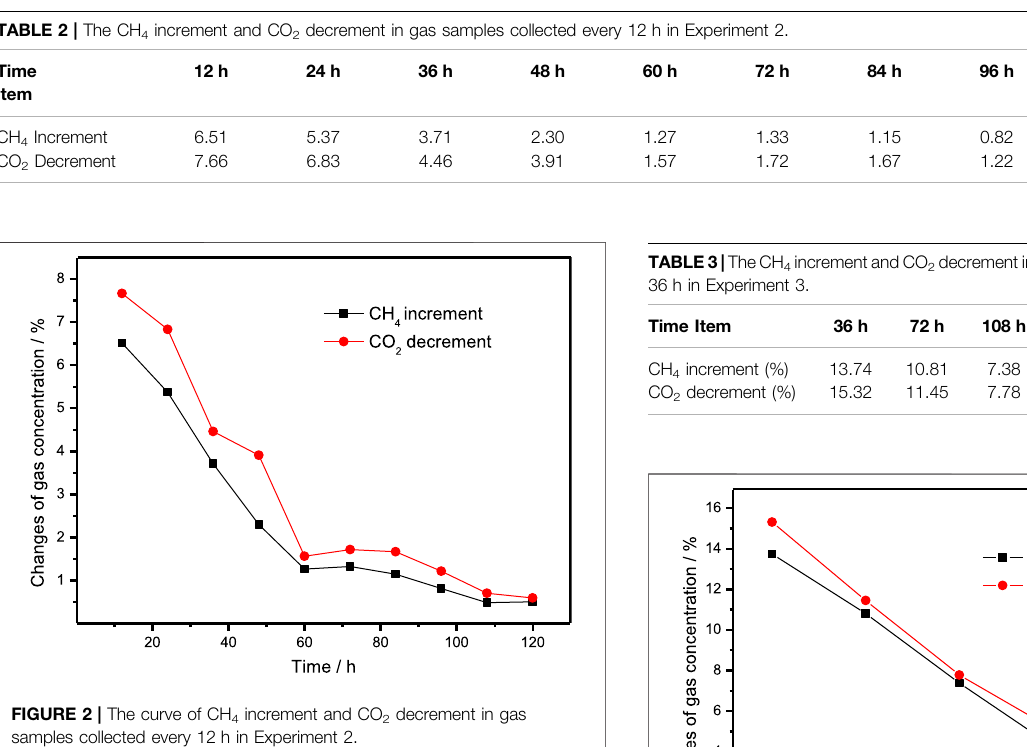
FIGURE 2 | The curve of CH 4 increment and CO 2 decrement in gas samples collected every 12 h in Experiment 2.